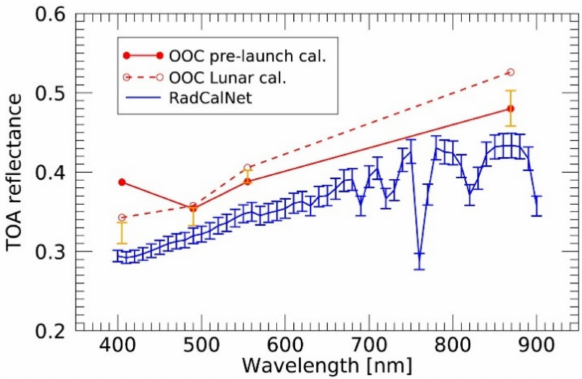
Figure 11. Top-of-atmosphere (TOA) reflectance spectrum of RadCaTS (blue) from RadCalNet and OOC observation (red). Both pre-launch calibration (solid line) and the current lunar calibration result (dashed line) are plotted, and the orange error bar indicates the potential spectrum change due to the superposed background illumination (see Section